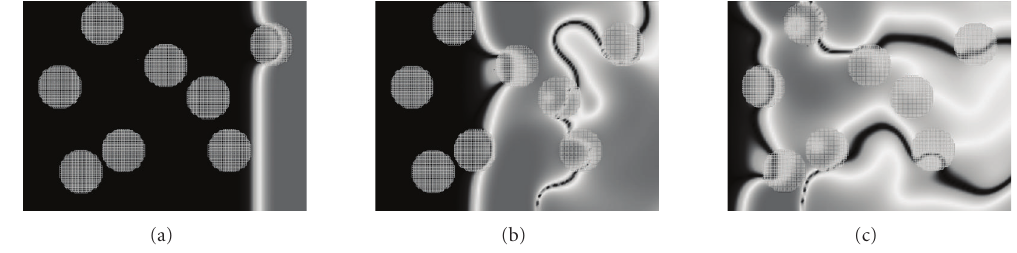
Figure 13: Plane wave propagating between randomly distributed small particles.